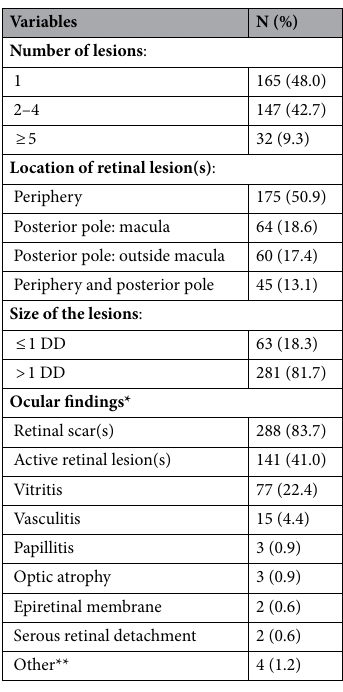
Table 2. Number, location, size of the retinal lesions and associated ocular findings at presentation (n = 344 eyes). DD = disc-diameter. *More than one posterior segment finding could be present per eye; **Macular edema (n = 1), choroidal neovascularization (n = 1), intraretinal hemorrhage (n = 1) and branch retinal vein occlusion (n = 1).